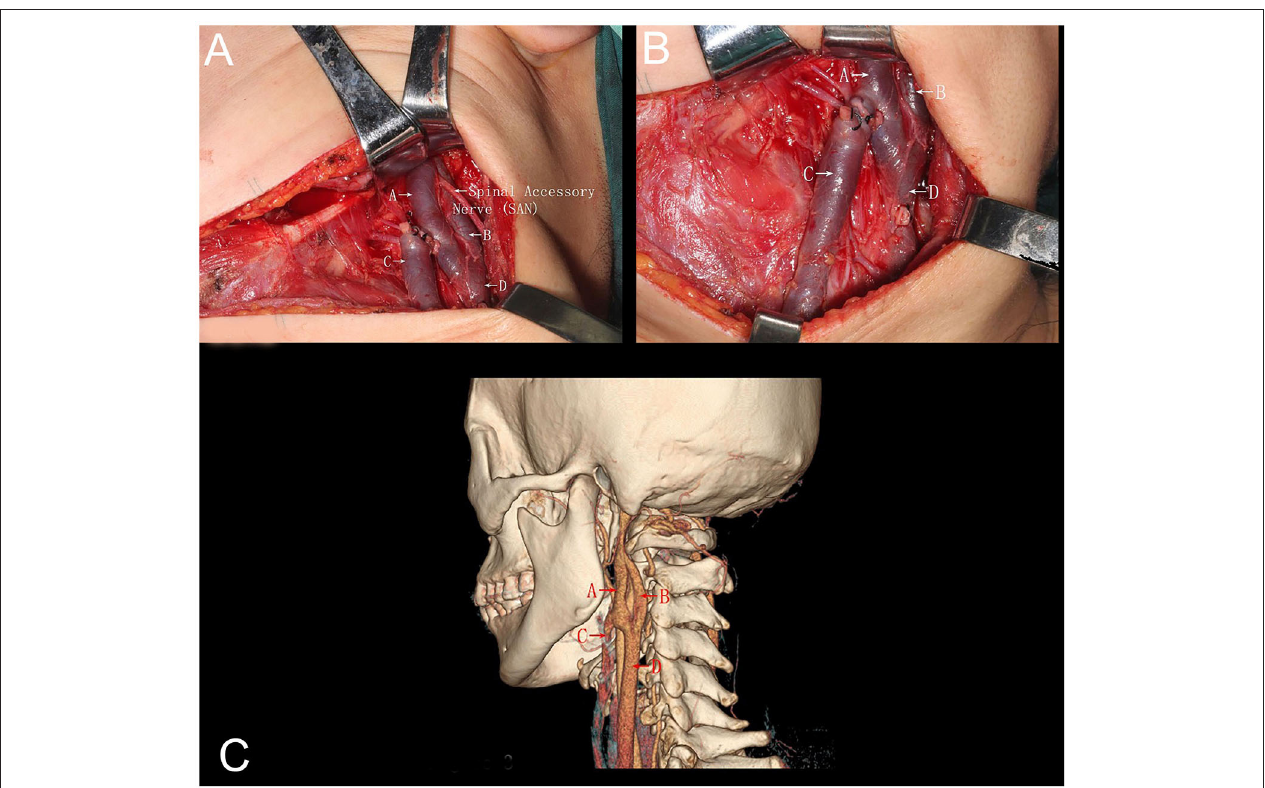
FIGURE 1 | (A) Intraoperative picture demonstrating a left-side neck dissection. The internal jugular vein divided into two branches anterior (A) and posterior (B) from its origin at the jugular foramen. Both branches run downwards parallel to each other for ∼ 4cm in length and fused back together (D), demonstrating a window-like opening between the two branches. The anterior branch of the internal jugular vein received blood from an anterior tributary vein (C). Additionally, the spinal accessory nerve transversed this fenestration (A, anterior branch internal jugular vein; B, posterior branch internal jugular vein; C, anterior tributary vein; SAN, spinal accessory nerve; D, internal jugular fusion after fenestration). (B) Intraoperative picture of a left-side neck dissection, demonstrating the course of the anterior tributary vein (C) running down on the anterolateral region and deep into the platysma (A, anterior branch internal jugular vein; B, posterior branch internal jugular vein; C, anterior tributary vein; SAN, spinal accessory nerve; D, internal jugular fusion after fenestration. (C) Three-dimensional computed tomographic angiography corroborating the intraoperative findings (A, anterior branch internal jugular vein; B, posterior branch internal jugular vein; C, anterior tributary vein; SAN, spinal accessory nerve; D, internal jugular fusion after